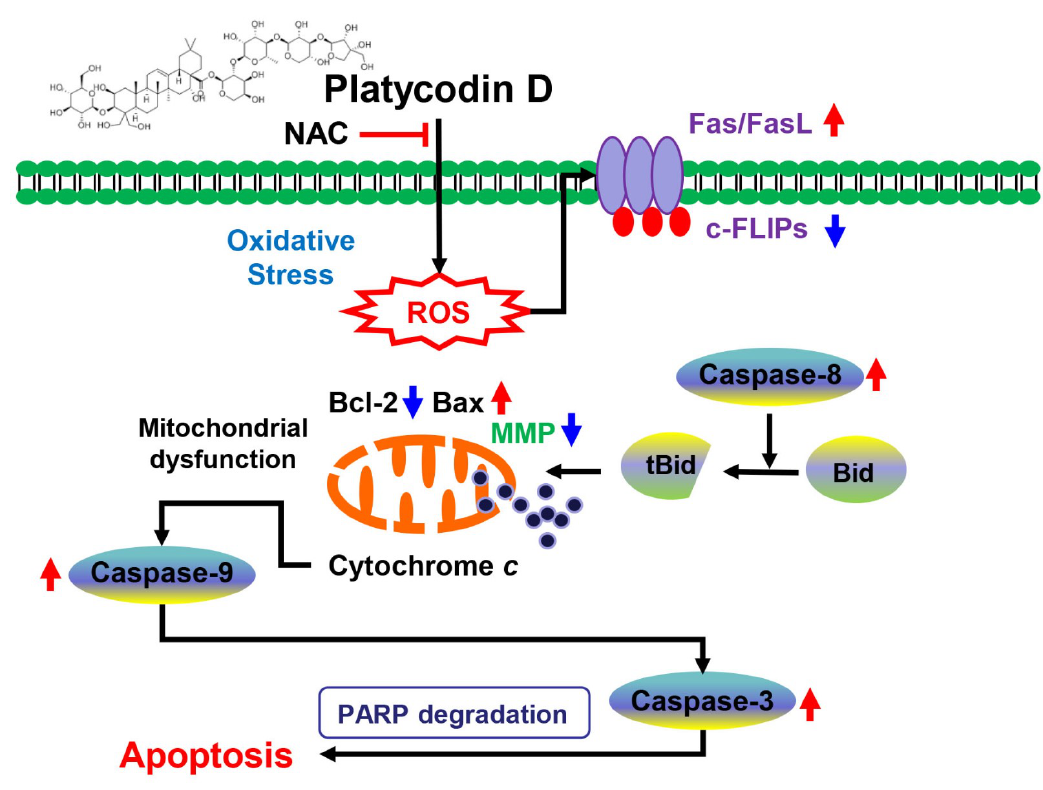
Fig. 6. Proposed model for PD-induced apoptosis in PC3 human prostate cancer